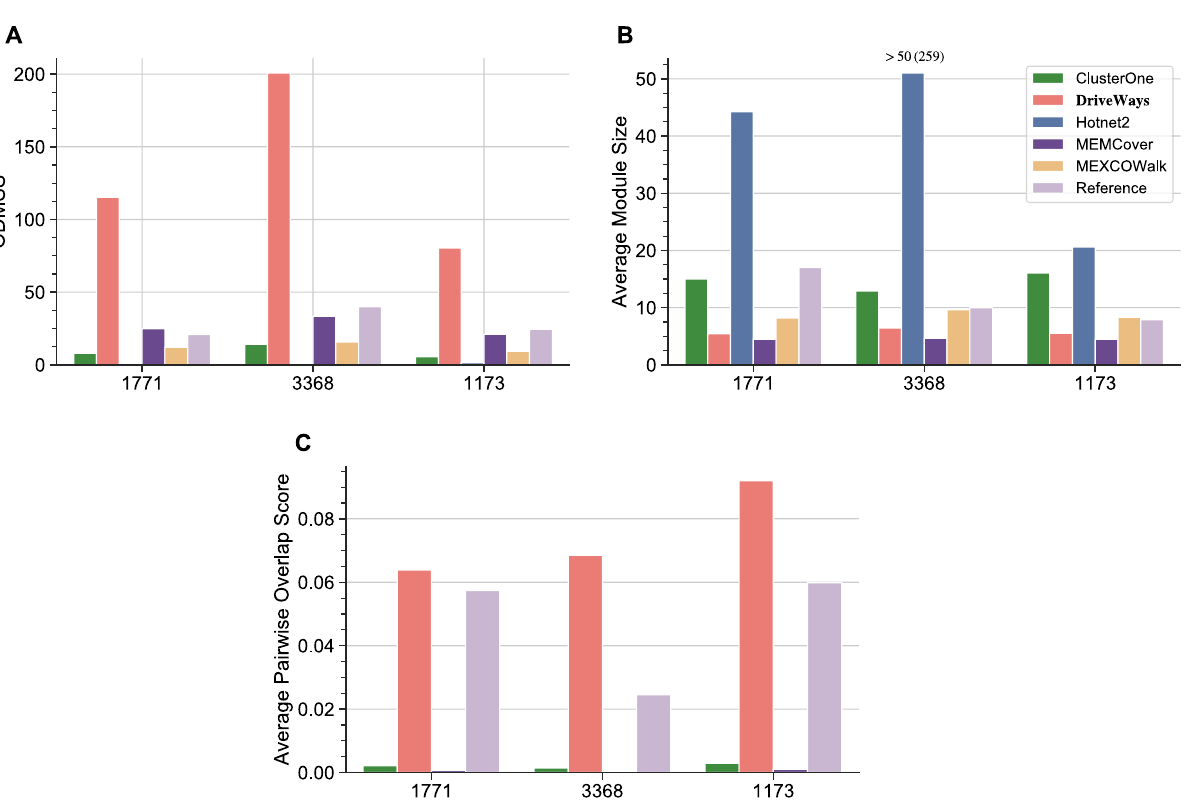
Figure 2. ( A ) ODMSS values for the outputs of all the methods when δ s is set to shown values. ( B ) Average module sizes in the outputs of the methods under consideration for the shown δ s values. ( C ) Corresponding average pairwise overlap